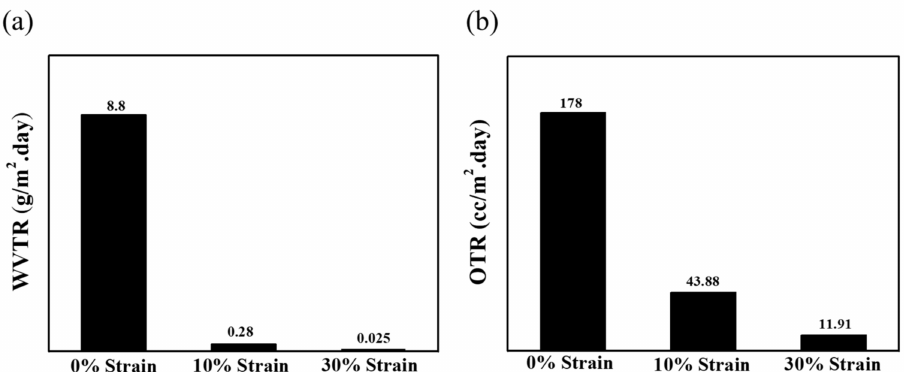
Figure 8. ( a ) WVTR and ( b ) OTR values of the prepared stretchable gas barrier